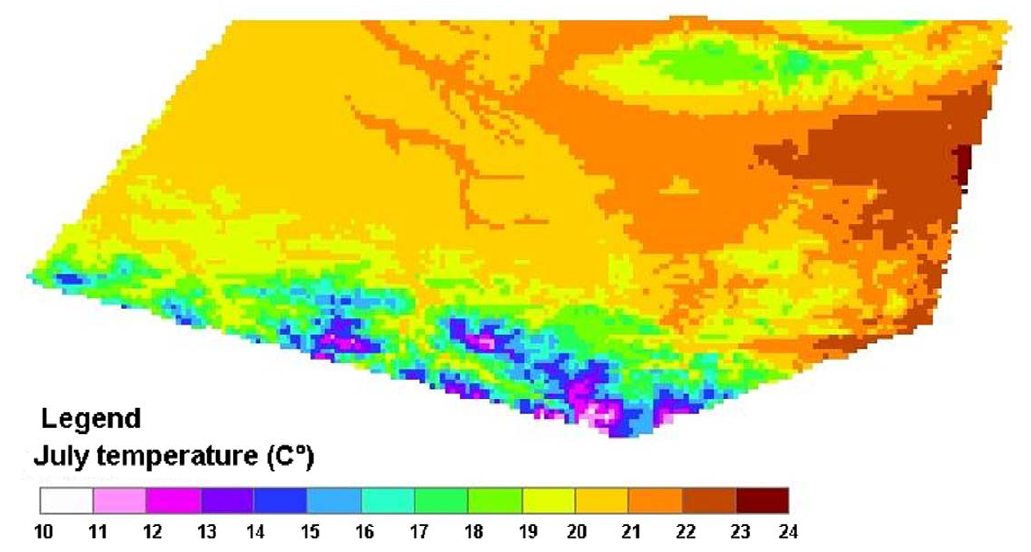
Figure 2. Temperature map of the study region: average temperature in July.